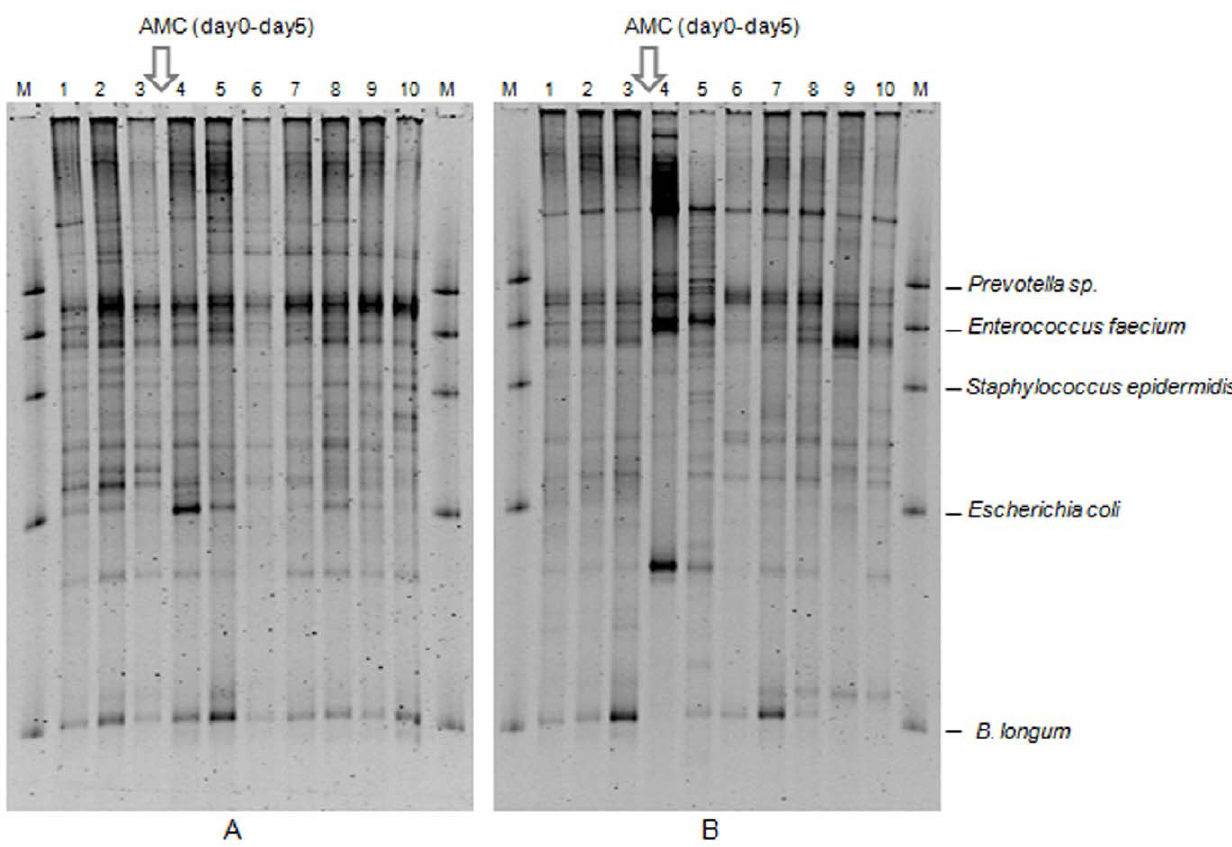
Figure 3. TTGE profiles representing the bacterial diversity of fecal samples from two healthy volunteers (A and B) before and after AMC exposure. 1: day-12; 2: day-6; 3: day 0; 4: day 5; 5: day 8; 6: day 12; 7: day 19; 8: day 26; 9: day 33; 10: day 64.